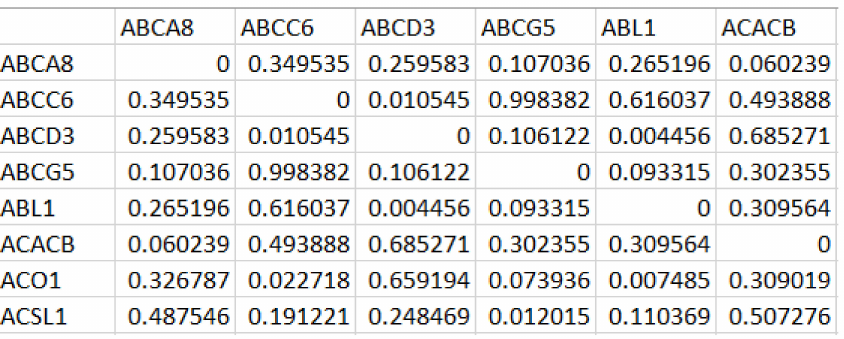
Figure 2. Correlation matrix generated from the Differentially Expressed (DE) gene set with rows and columns corresponding to the differentially expressed genes, and each cell holds the measure of the difference in correlation values across the